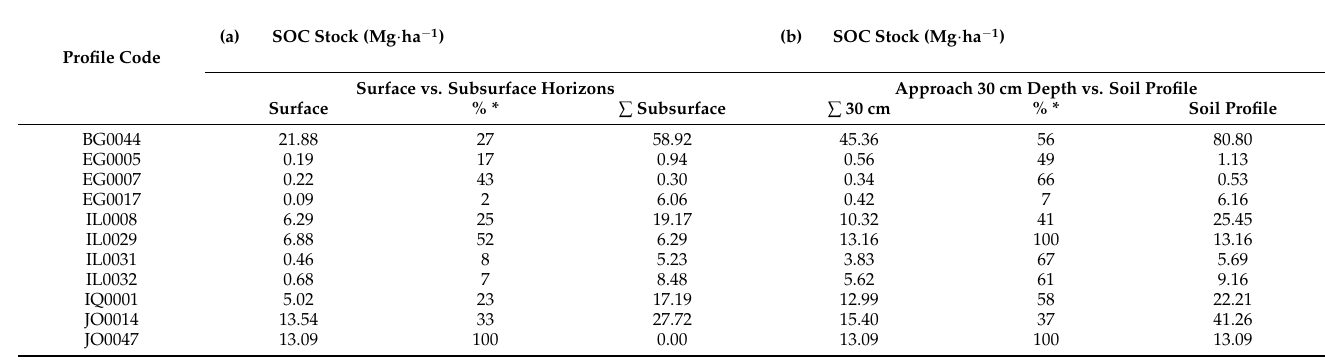
Table 2. SOC stocks in the studied soil profiles: (a) comparison of stocks from surface horizons and sum of stocks in subsurface horizons; (b) comparison of stocks assuming a 30 cm sampling and total SOC stocks of complete soil